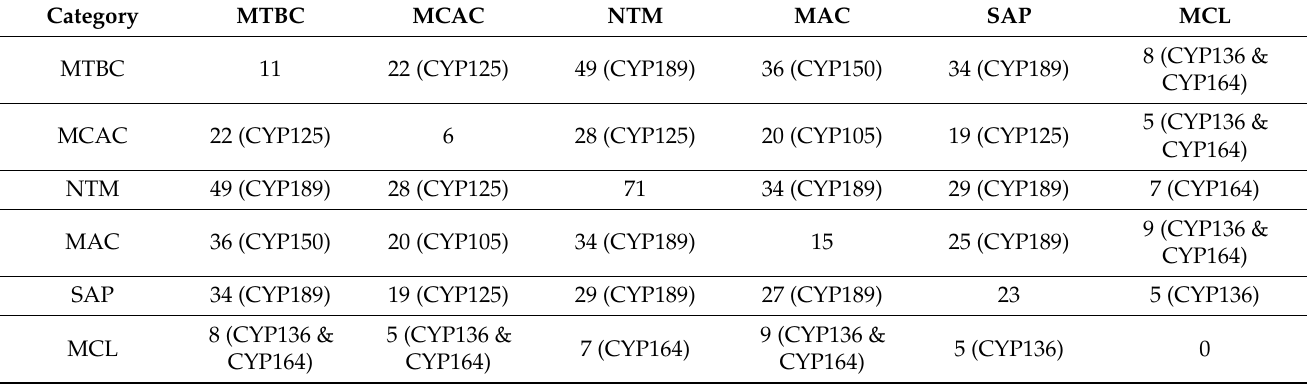
Table 4. Analysis of unique and shared P450 families among mycobacterial categories. The